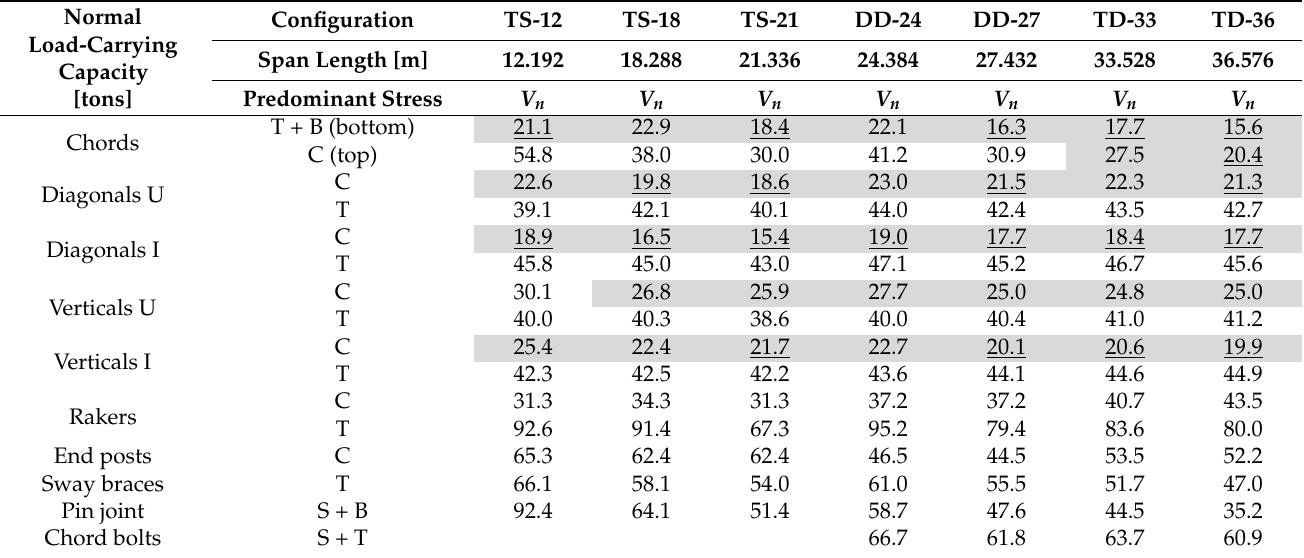
Table 3. Normal load-carrying capacities of main girders